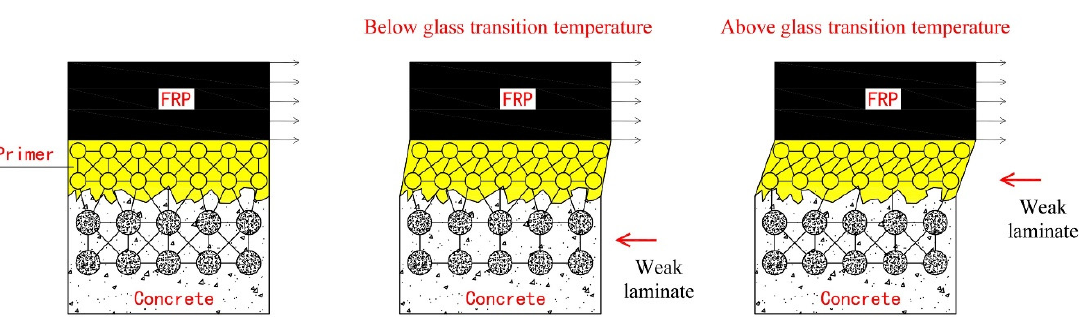
Figure 12. Schematic illustration of the degradation mechanism.